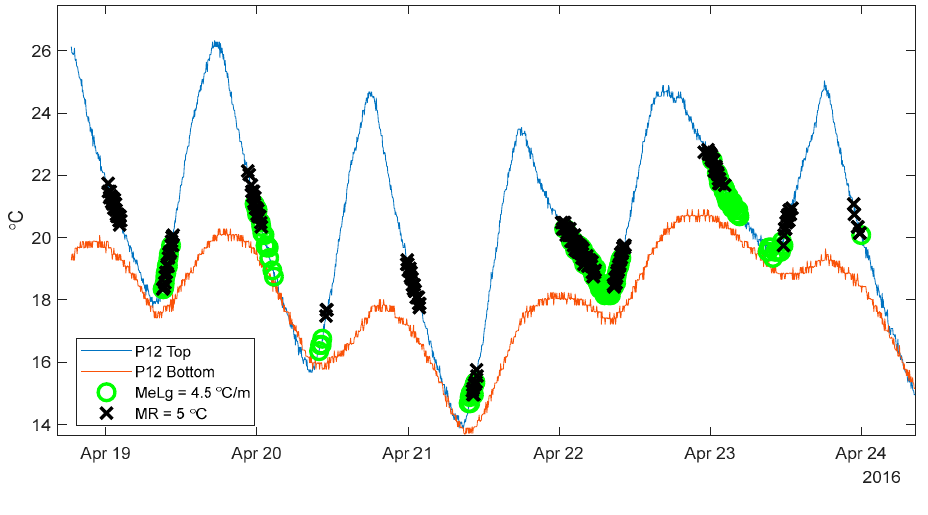
Figure 15. MR and MeLG Comparison, Pier 12.